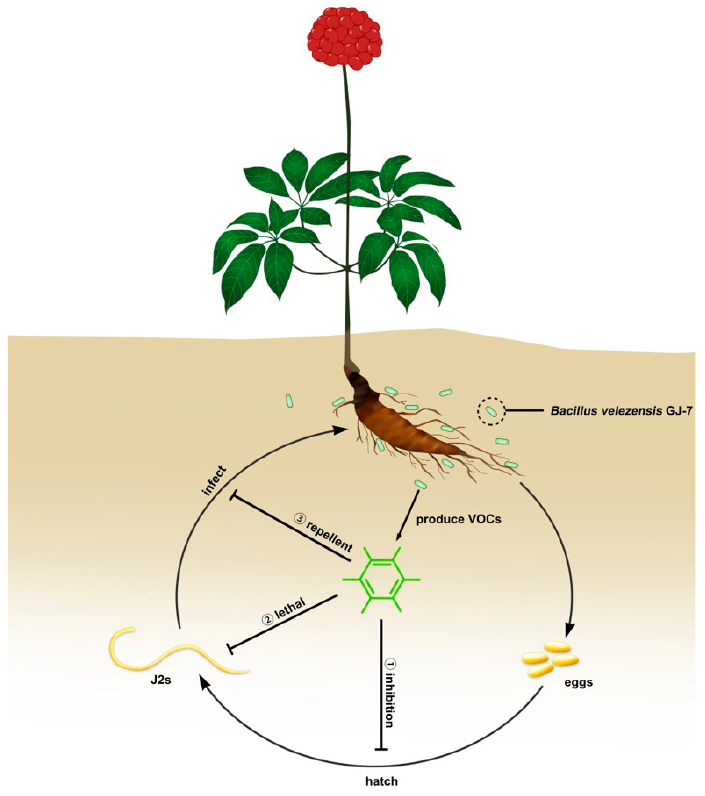
Figure 6. Action modes of VOCs of Bacillus velezensis GJ-7 against root-knot nematodes.